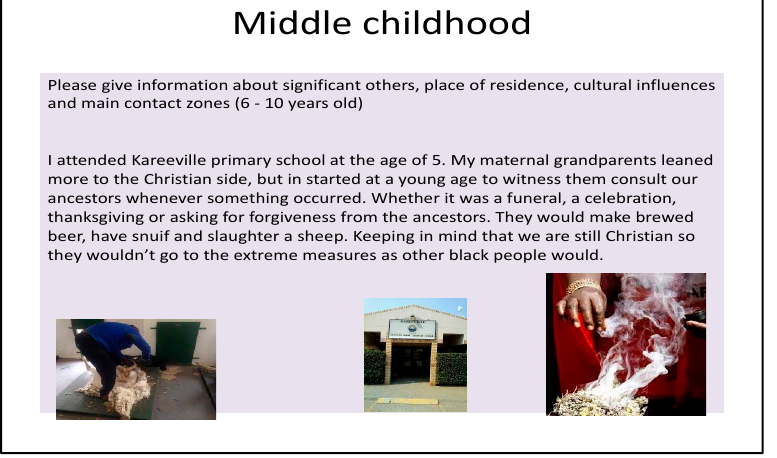
Figure 2. Lihile’s early childhood phase.